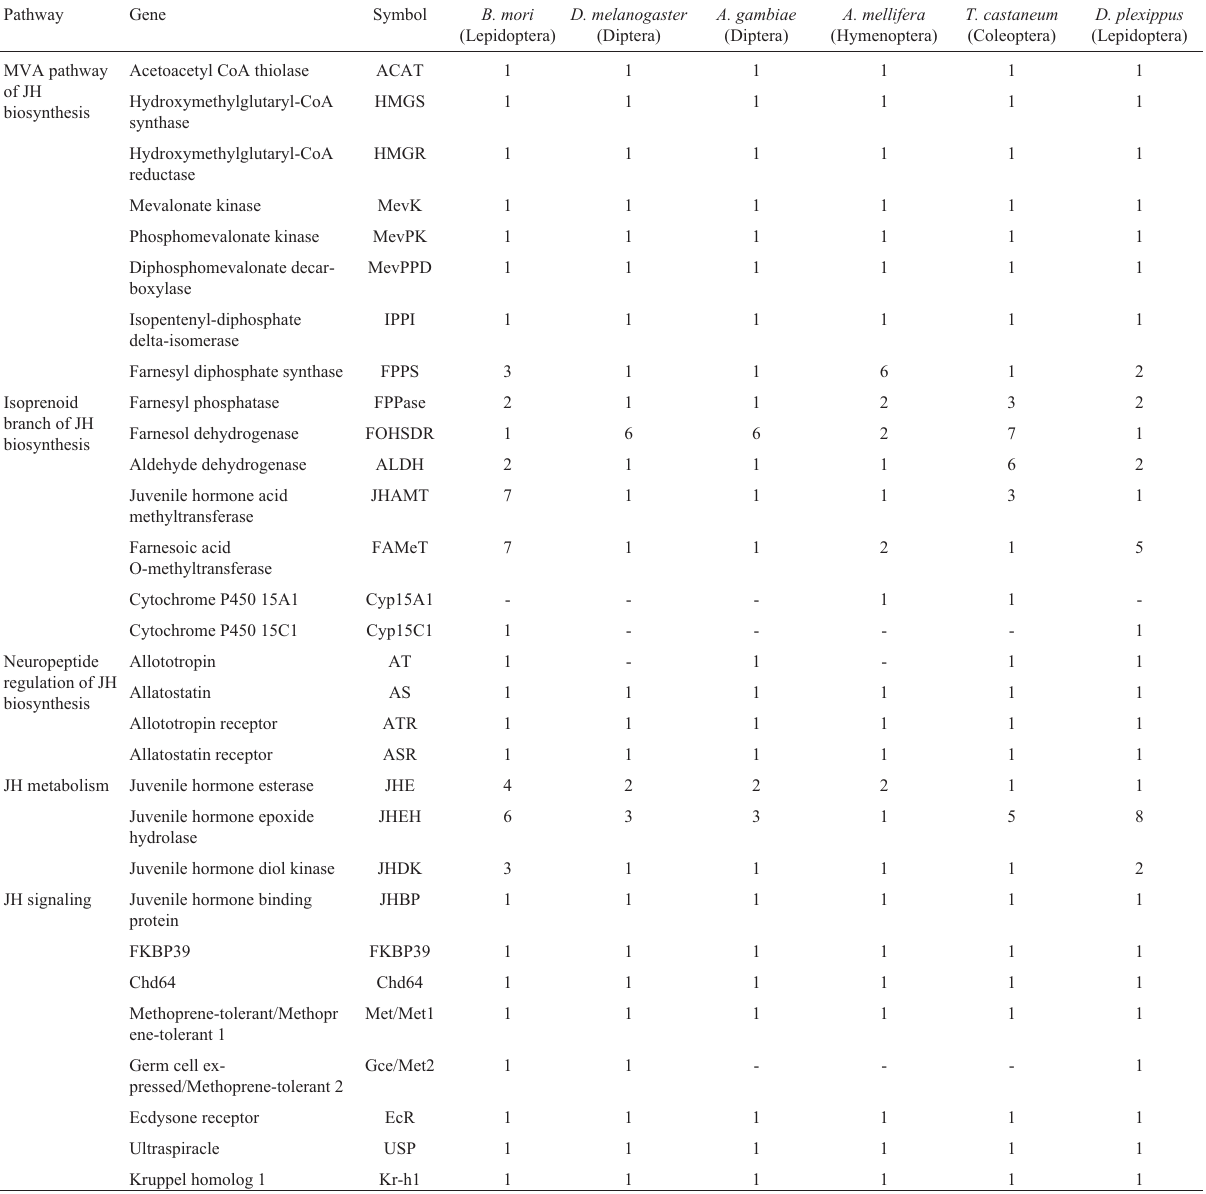
Table 2 - Copy number of JH-related genes in B. mori and the other insects. Pathway